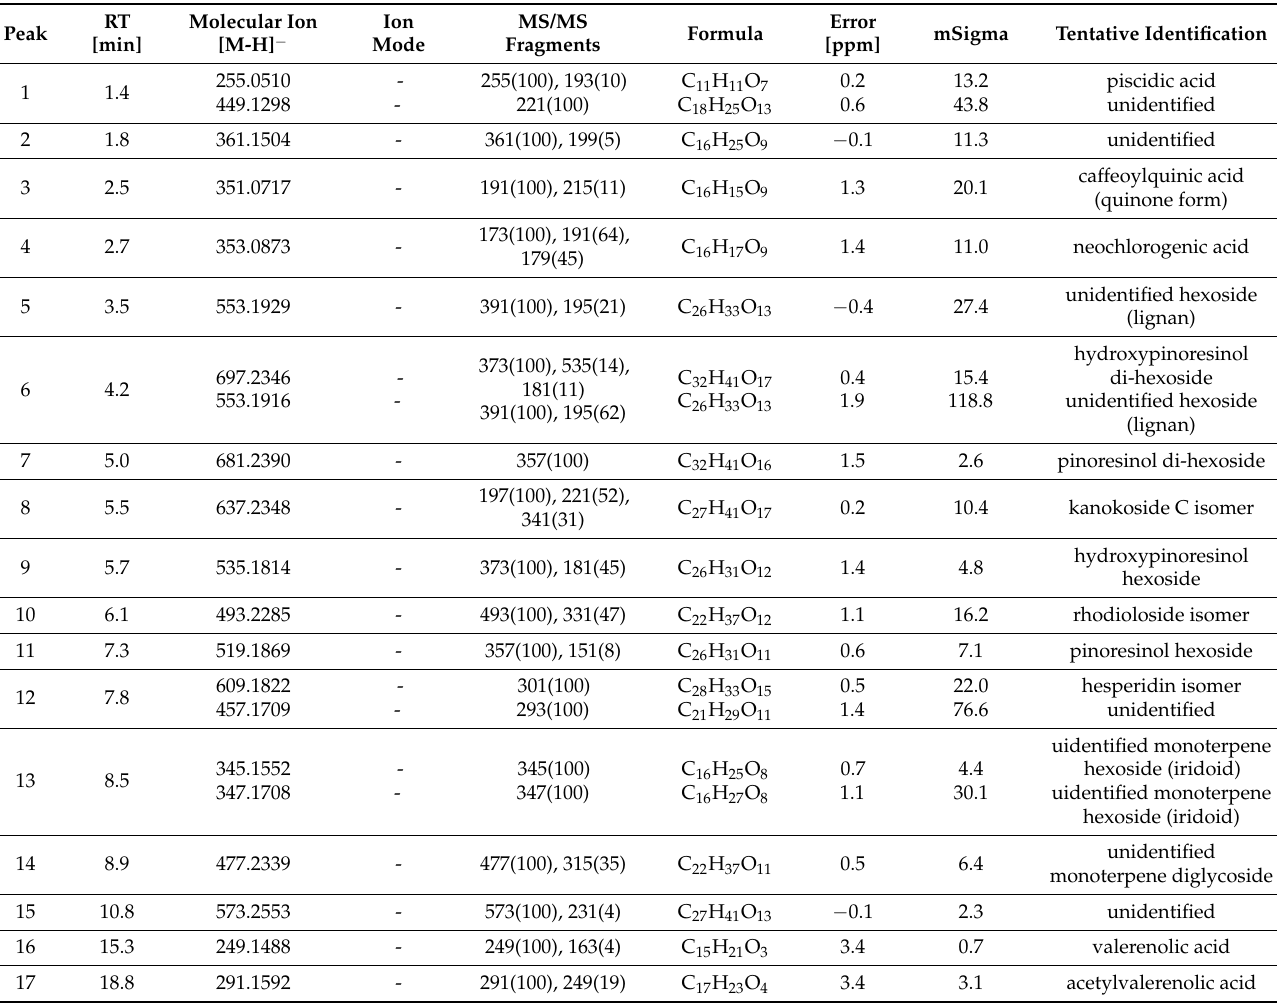
Table 3. Compounds identified in the valerian ( Valeriana officinalis L.) extract using UHPLC-QTOF-MS/MS. Compound numbers correspond to those indicated in Figure 2.